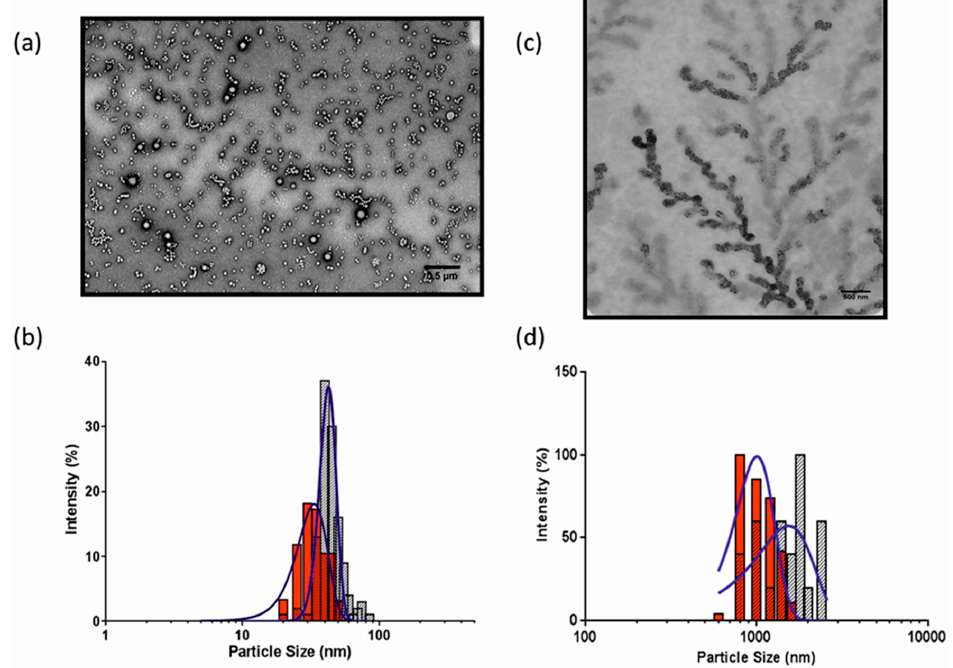
Figure 1. ( a )Transmission electron microscopy (TEM) of poly(2-methyloxazoline)–poly(dimethylsiloxane)–poly(2-methyloxazoline) (PMOXA–PDMS–PMOXA) polymersome sample produced via the adapted slow aqueous addition method; ( b ) comparison of TEM (Grey bars) grainsizing and Dynamic Light Scattering (DLS) (Red bars) sizing data show an average size of 45 nm compared to 32 nm, respectively, and a polydispersity index of 0.5; ( c ) TEM of PMOXA–PDMS–PMOXA polymersomes produced via the previously published method with excess ethanol (excess ethanol method) [26] shows the presence of polymer networks and ( d ) the corresponding TEM (Grey bars) and DLS (Red Bars) grainsizing showing an average size of 1.8 µm and 800 nm respectively.